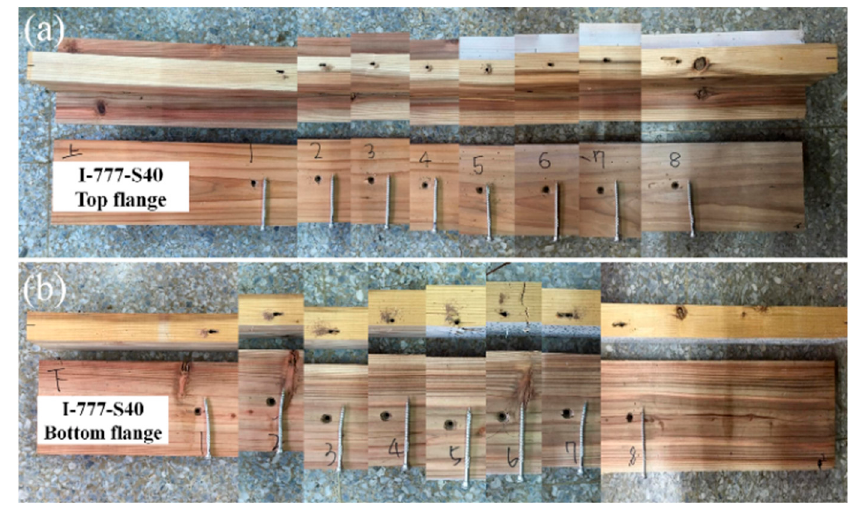
Figure 10. Distortional deformation of the screws of the built-up I-beam ( a ) the top flange of I-777-S40; ( b ) the bottom flange of I-777-S40.